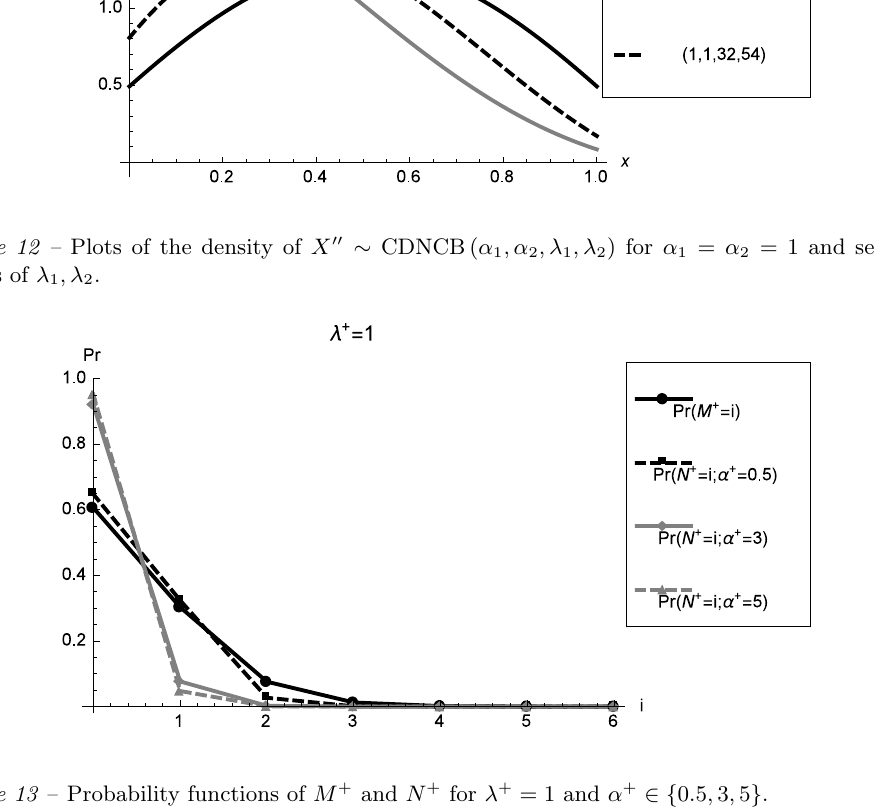
Figure 13 { Probability functions of M + and N + for (cid:21) + = 1 and (cid:11) + 2 f 0 : 5 ; 3 ; 5 g